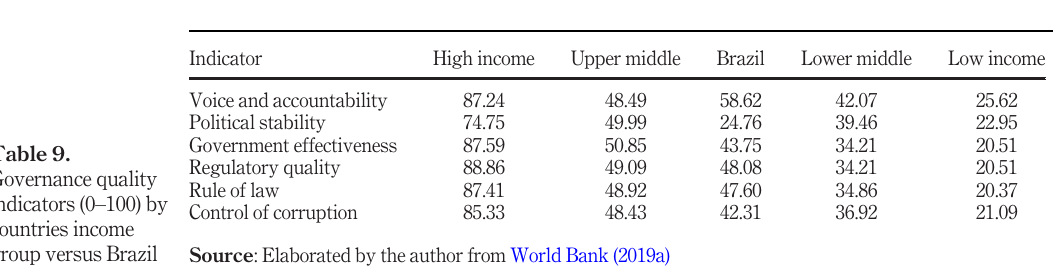
indicators (0 – 100) by countries income group versus Brazil